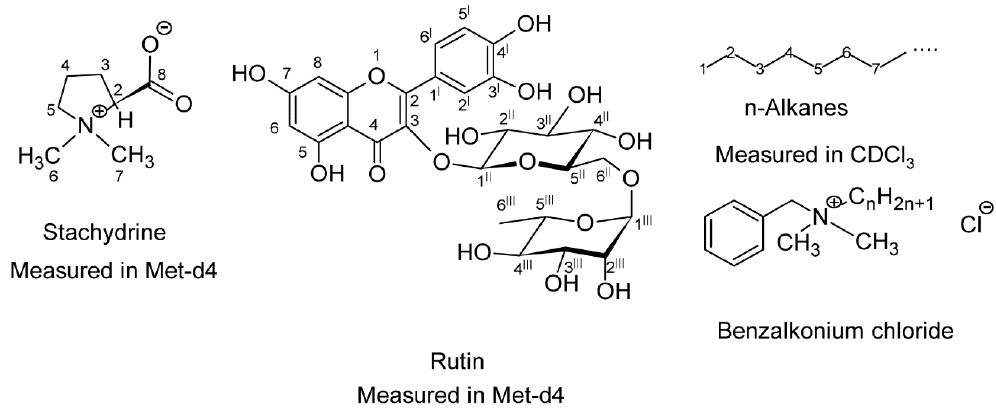
Figure 3. The chemical structure of the three major compounds presents in the M8R